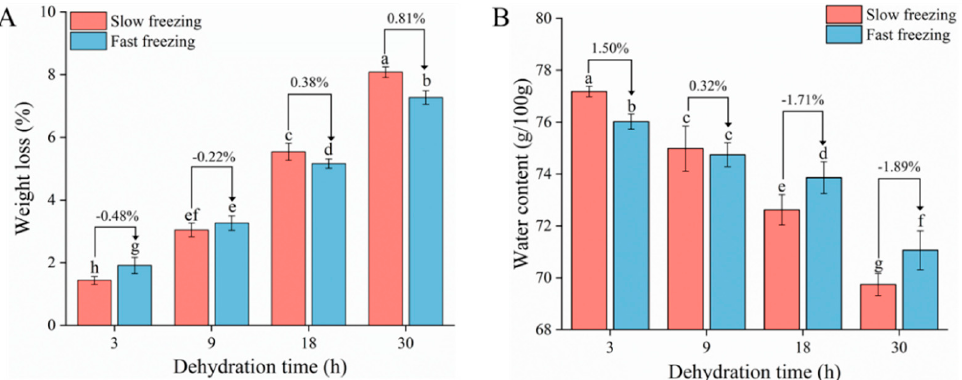
Figure 1. Effect of dehydration treatment on weight loss ( A ) and water content ( B ) of large yellow croaker. Different lowercase letters in the same index indicate significant differences ( p < 0.05). The water content of the fresh sample (CK) was 83 ±